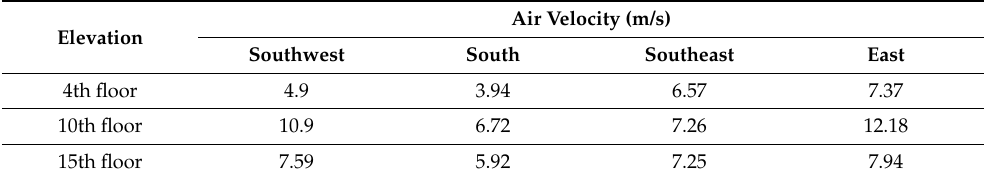
Table 4. Field measurement data used in the simulation.